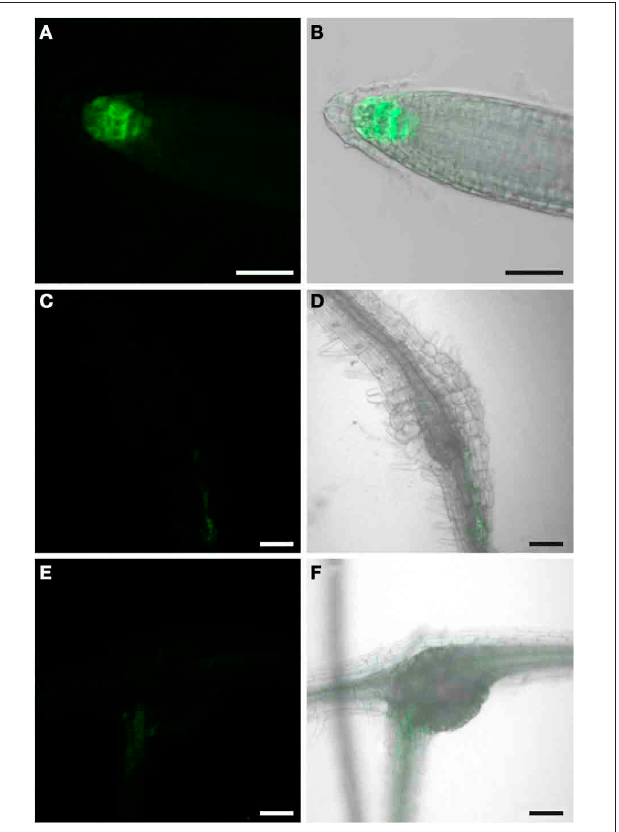
FIGURE 10 | GFP fluorescence in Arabidopsis plants expressing ER-GFP under the control of the TCS-promoter. Fluorescence is observed in cytokinin responsive tissues. (A,B) GFP fluorescence in the root tip of a 2 week old P TCS :ER - GFP plant. (A) GFP fluorescence. (B) Overlay of GFP fluorescence and bright field image. (C,D,E,F) GFP fluorescence in M. incognita –induced root-knots in P TCS :ER - GFP plants at 7dai (C,D) and 14dai (E,F) . Throughout development staining was diffuse and virtually absent from root knots. (C,E) GFP fluorescence. (D,F) Overlay of GFP fluorescence and bright field image. Scale bars represent 50 µ m in (A,B) and 100 µ m in (C – F)